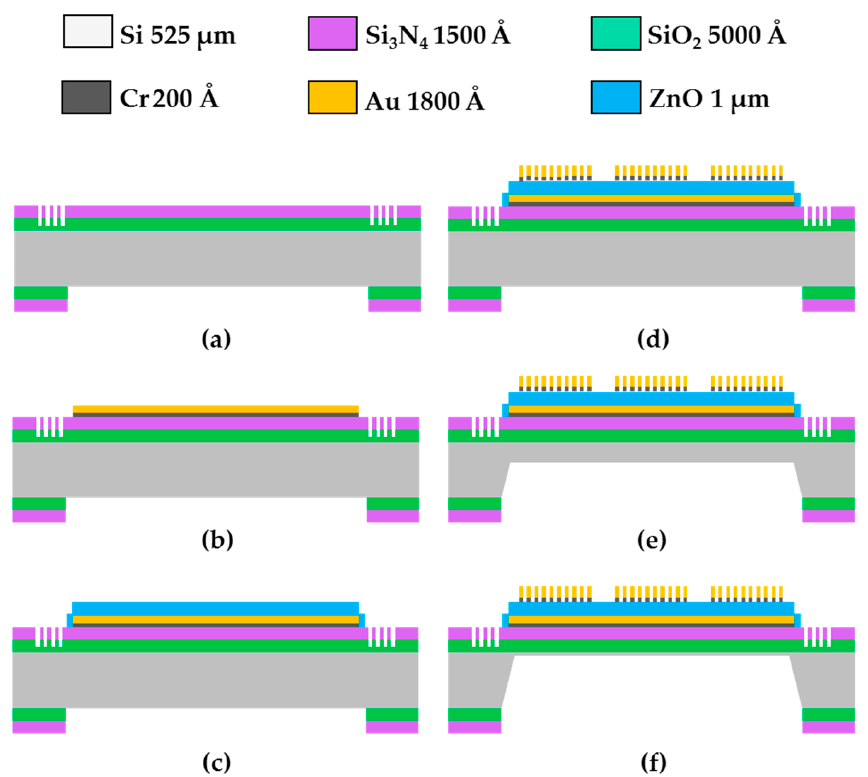
Figure 3. Main processing steps of the proposed FPW transducer: ( a ) 0.5/0.15- μ m-thick SiO 2 /Si 3 N 4 deposition, 0.3- μ m-deep Si-groove RGS etching, and backside SiO 2 /Si 3 N 4 patterning; ( b ) 0.02/0.15- μ m-thick Cr/Au ground electrode deposition and patterning; ( c ) 1- μ m-thick ZnO deposition and patterning; ( d ) 0.02/0.18- μ m-thick Cr/Au IDT deposition and patterning; ( e ) anisotropic etching of the backside silicon using 30 wt% KOH at 60°C for 35.5 h; and ( f ) 27°C for 6.85 h.